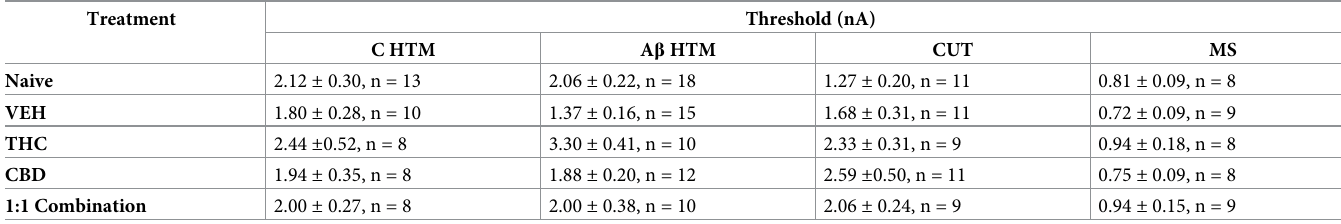
Splenic male and female CD4+ T cell-associated marker expression A graphical summary of splenic qPCR results in endpoint-collected tissues is shown in the middle panel of Fig 4. An examination of splenic sham Il2 (Fig 4A; P = 0.0412, t-test), Ifng (Fig 4B; P = 0.2419, t-test), and Tnfa (Fig 4C; P = 0.0828, t-test) mRNA levels revealed that only Il2 levels differed significantly between the sexes, being higher in female relative to male sham- operated animals. The Il2 mRNA level did not fluctuate significantly in males across any of the groups (Fig 4A; male 1-way ANOVA: F = 0.6713 and P = 0.6176). In contrast, the splenic Il2 expression profile for the female comparison mirrored results obtained in the thymus for this T cell marker, with nerve cuff-implanted VEH-treated rats having a significantly lower Il2 mRNA level compared to shams, and treatment with THC, CBD, and the 1:1 combination of both cannabinoids sex-specifically returning the expression of Il2 to the level obtained in the female sham group (Fig 4A; female 1-way ANOVA: F = 4.823 and P = 0.0044). Splenic Ifng lev- els were not significantly affected by the presence of a nerve cuff in males relative to sham- operated counterparts, with cannabinoid treatments having no major effects in males (Fig 4B; male 1-way ANOVA: F = 3.296 and P = 0.0241), while in females, none of the groups differed Table 6. Female activation thresholds of sensory neurons in response to intracellular current injection tested to determine differences in soma excitability in response to cannabinoid treatment.